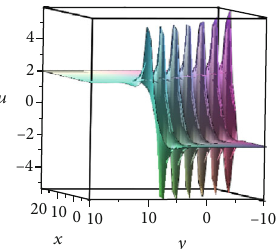
Figure 7: Spatiotemporal structure of solution (25) with the parameter selections a 1 = 1 , a 6 = 1 , a 7 = 1 , k 2 = 1 , δ 1 = 1 , δ 2 = 1 , = 1 , and δ = 1 . δ 3 5